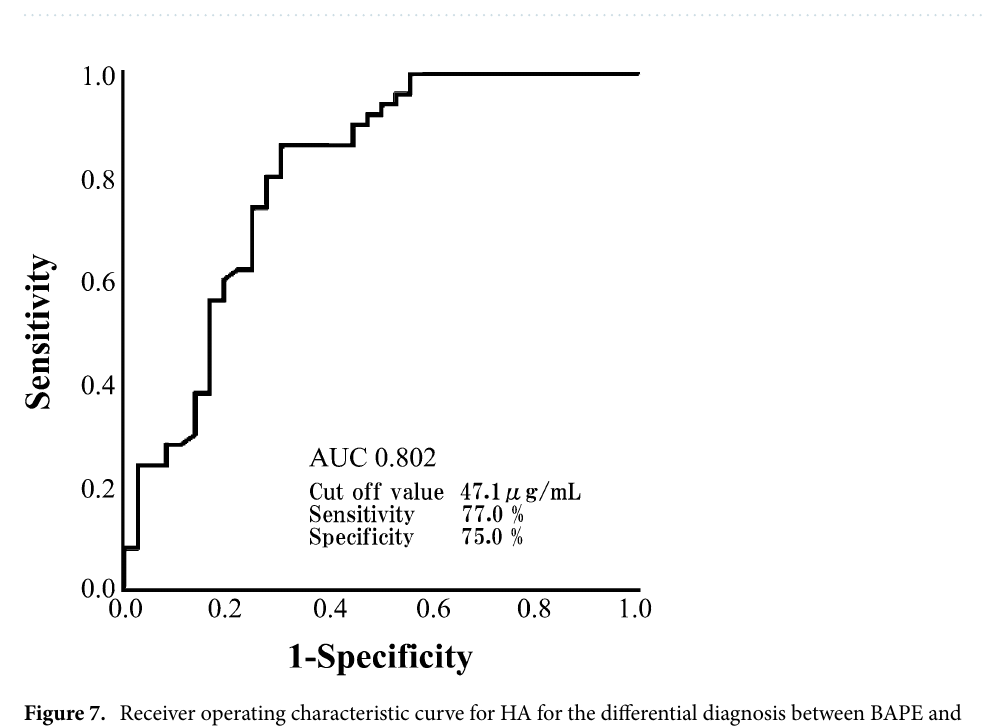
Figure 6. Receiver operating characteristic curve of SLPI for the differential diagnosis between BAPE and MPM. BAPE benign asbestos pleural effusion, MPM malignant pleural mesothelioma, SLPI secretory leukocyte peptidase inhibitor (SPSS Statistics V26 for IBM Japan (https:// www. ibm. com/ jp- ja/ produ cts/ spss- stati stics)).